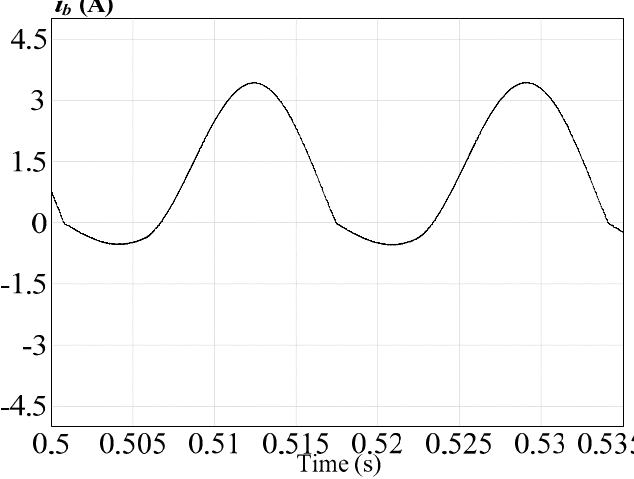
Figure 6. Waveform of line current i b for an inverter working at 60 Hz with faulty switch S b 2 − .